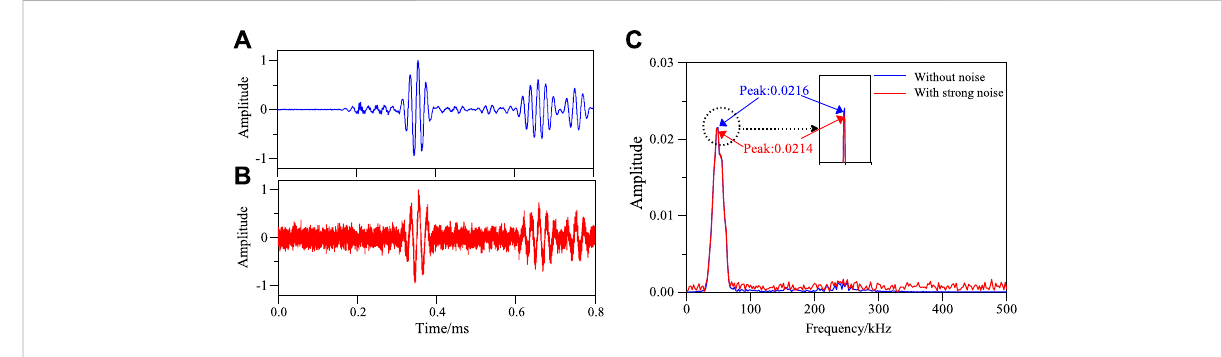
FIGURE 23 Frequency spectrum of S1 – S7 sensing channel without damage in structure under strong noise environment. (A) Effective signal-undamaged. (B) After adding 3 dB with noise. (C) Frequency spectrum of S1 – S7 signal sensing channel.